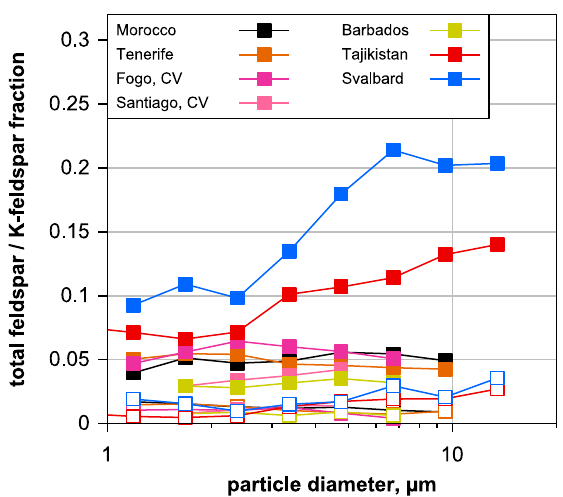
Figure 4. Feldspar particle number abundance relative to the total deposited silicate particles as a function of aerodynamic particle diameter. Filled symbols show the total feldspar abundance, whereas open symbols depict the K-feldspar one. Only data points with less than 30% relative counting error (central 95% confidence interval, Poisson statistics) are shown.